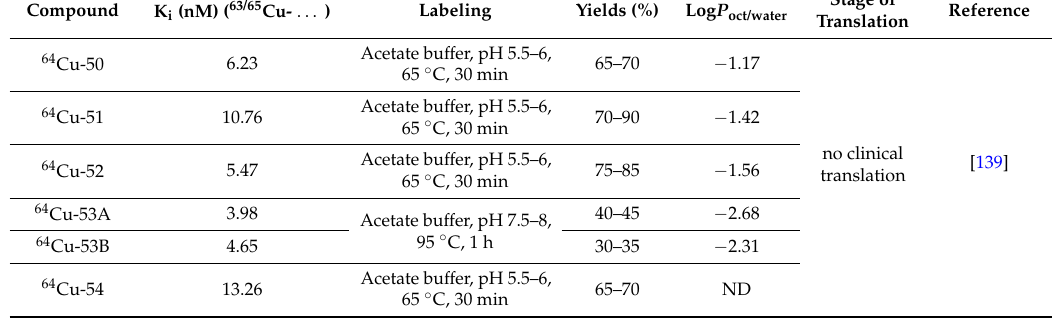
Table 6. Affinity, labeling and lipophilicity data of the 64 Cu-labeled PSMA inhibitors 50 – 54 .